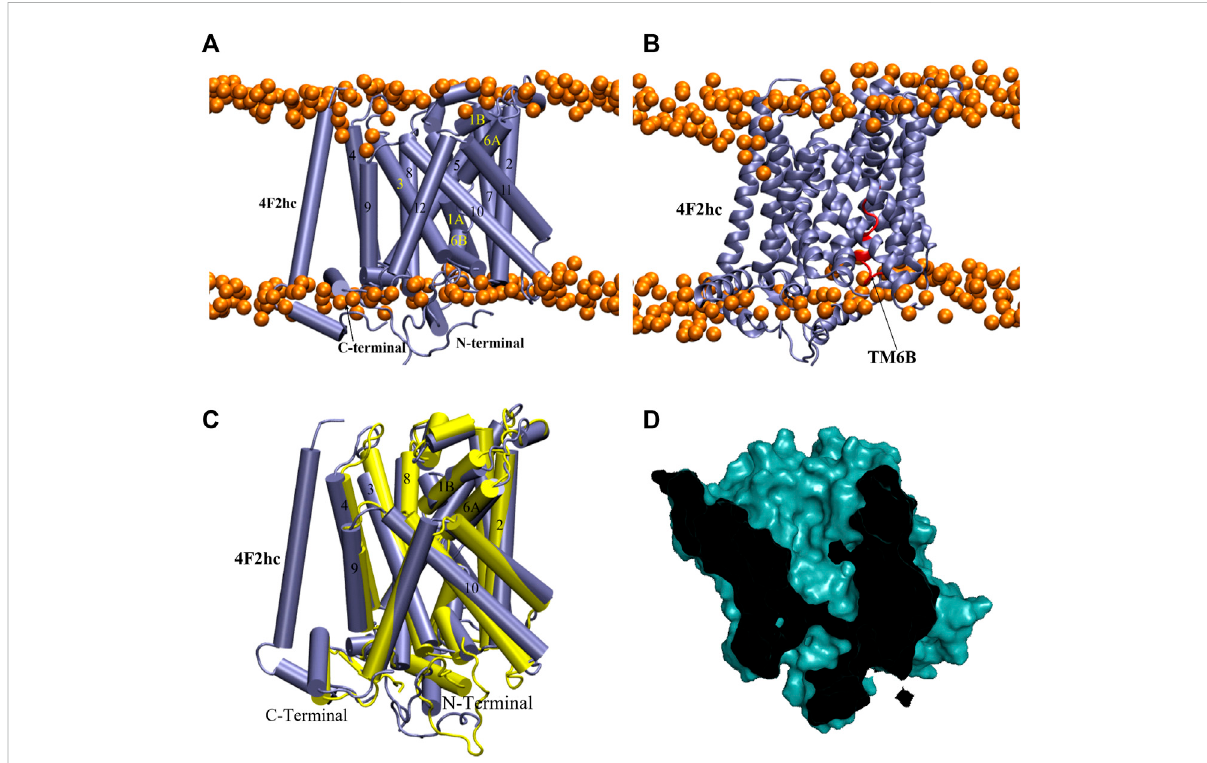
FIGURE 9 MD simulation structure of outward-open model. (A,B) Representative equilibrium snapshot of model 252 at 226.0 ns in membrane. The intracellularsurfaceisatthebottom. (C) Structuraloverlayofmodel 252 beforeandafterMDsimulation(yellowandice-blue,respectively). (D) Sliced surface representation at 226.0 ns.